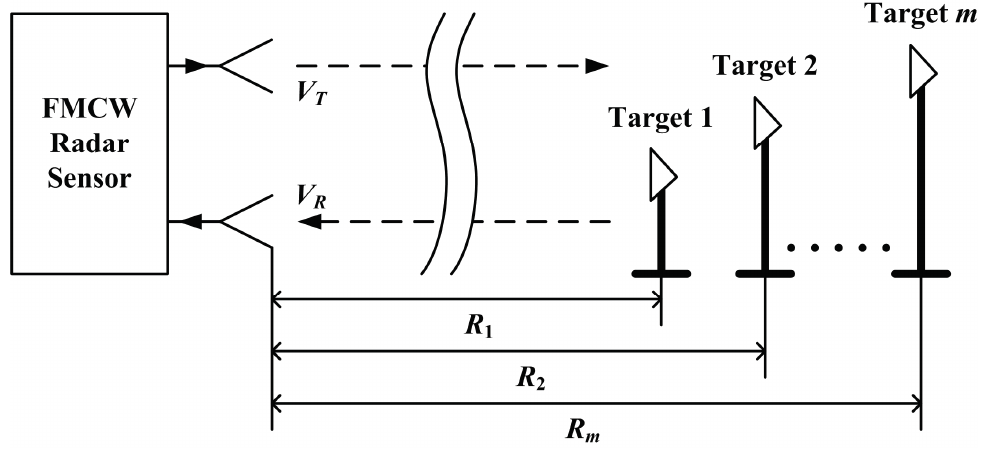
Figure 5. The measuring scheme for multiple targets based on FMCW radar